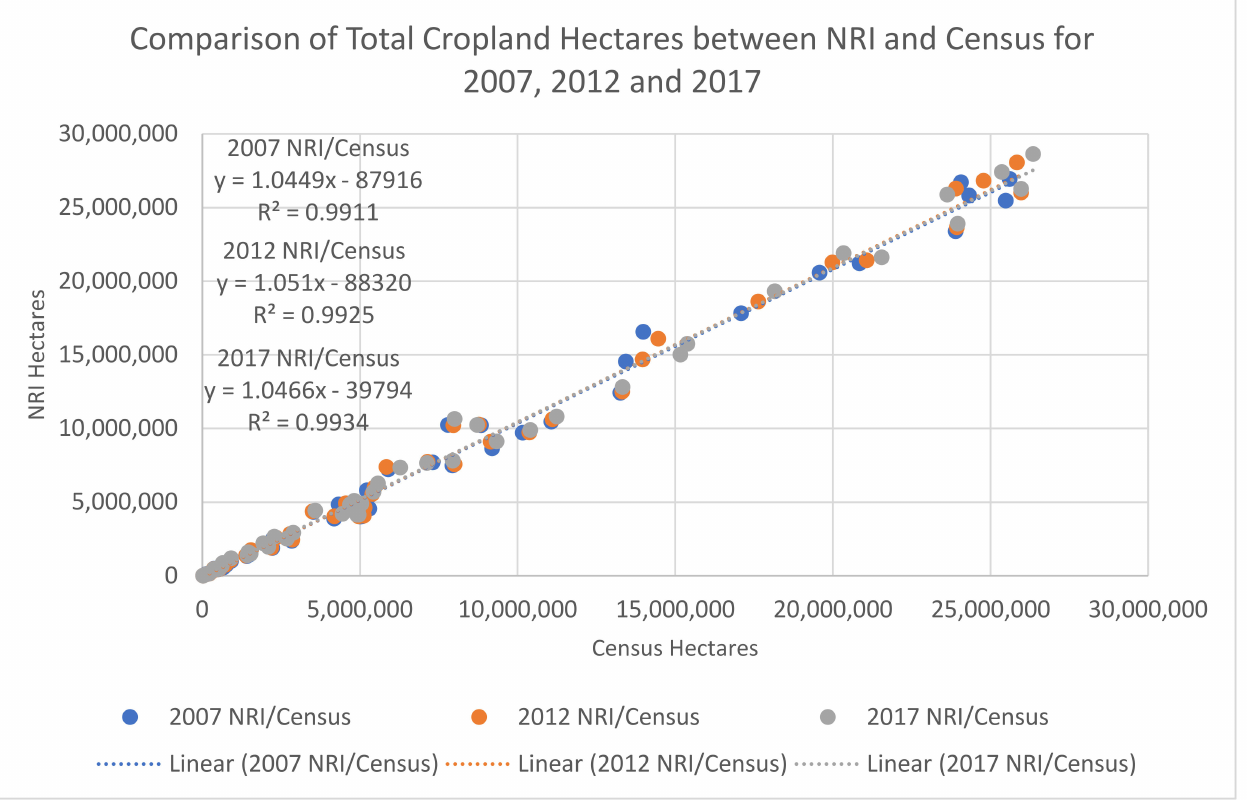
Figure 1. Relationship between reported total cropland area in the NRI and Census for 2007, 2012 and 2017. A comparison of total cropland area estimated from the 2007 CDL at the state level (for the 20 states available) to total cropland area estimated from the NRI and Census for the same year is shown in Figure 2. The total cropland area from the 2007 CDL was strongly correlated with those estimates from the NRI ( R 2 = 0.98) and Census ( R 2 =0.96). Totals for each dataset across the 20 states indicated that the CDL tended to estimate less cropland compared to the other two datasets. For example, the NRI, Census, and CDL estimated total croplands approximately 106 million hectares, 113 million hectares, and 97 million hectares, respectively. The total cropland area estimated using the 2007 CDL was 8.5% and 14.0% smaller than the estimates from the NRI and Census. Total cropland area estimated